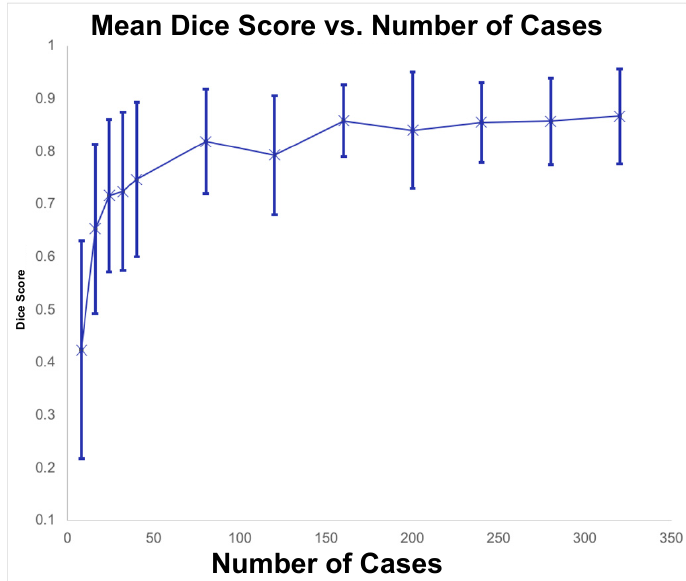
Figure 3. Dice score improved the most between 8 cases and 16 cases (0.424 to 0.653). The Dice score started to plateau after 160 cases which had a performance of 0.858. The Dice score only improved by 0.09 from 160 cases to 320 cases. The Dice score was plotted with error bars that show the standard deviation above and below that run’s mean Dice score. The standard deviation was lowest at 0.076 with 240 cases and highest at 0.206 with 8